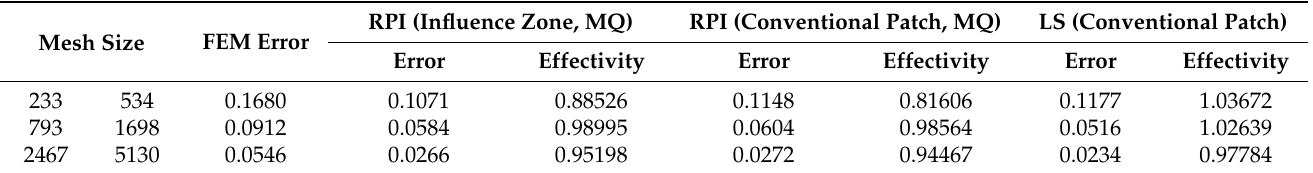
Table 8. Error properties found for LS- and RPI (MQ)-based recovery approach in incompressible- elastic analysis for plate with rigid circular opening considering influence zones and conventional patches. (Four-node quadrilateral equal elements).